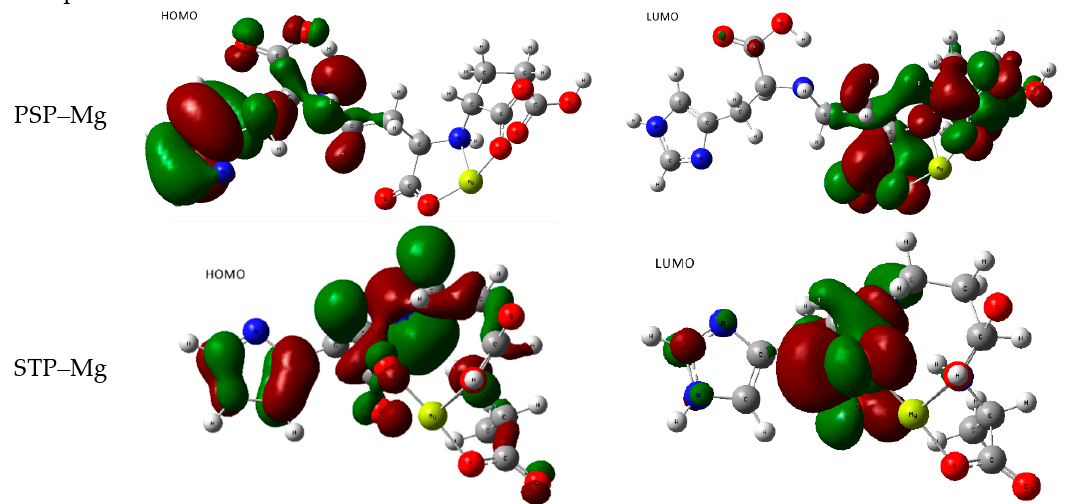
Figure 4. FMOs of pseudopaline (PSP) and staphylopine (STP) complexes with the alkaline earth Mg ion as an example. Indeed, the respective Mg regions show no MOs around the ion, thus